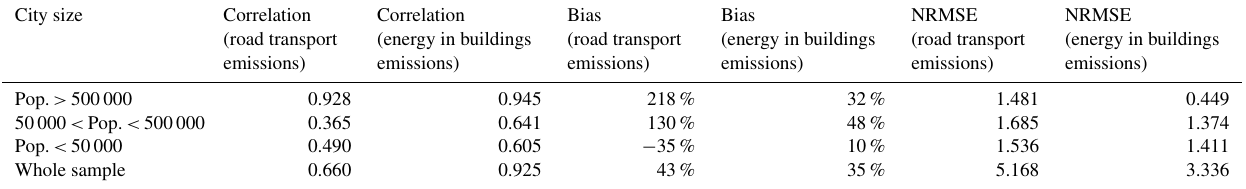
Table A2. Benchmark indicators for road transport and energy in buildings sectors in EDGAR v5.0 and GCoM datasets of selected signato-